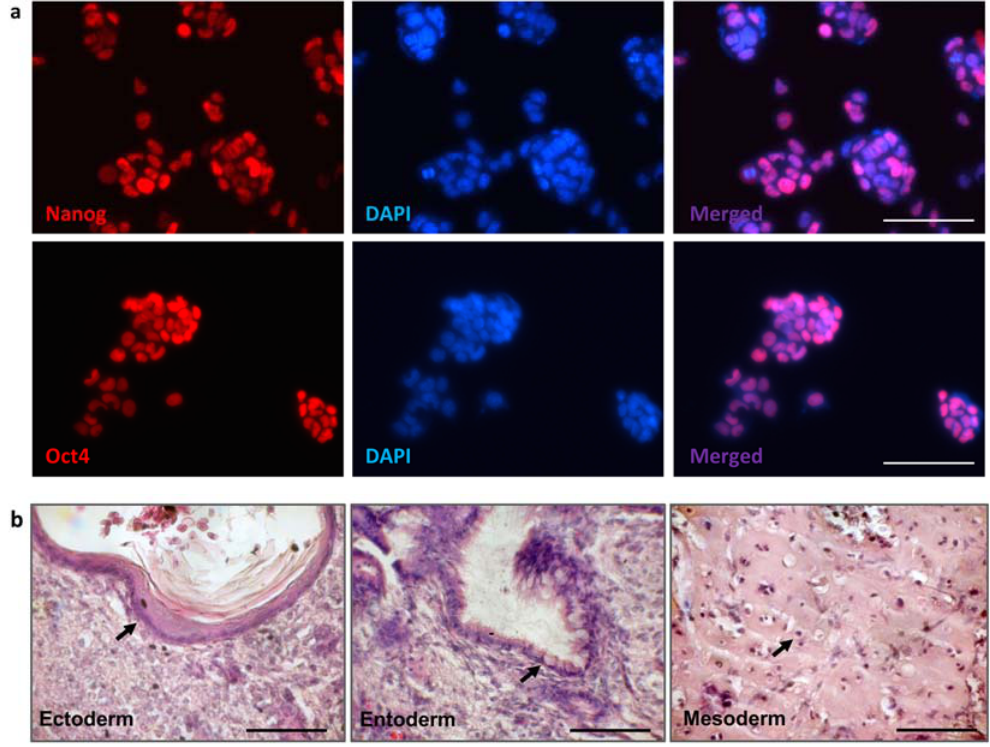
Figure 3. Expression of the pluripotency markers and teratoma formation by induced pluripotent stem cells (iPSCs) developed from FVIII Y / - fibroblasts. ( a ) Immunostaining of FVIII Y / - iPSCs with anti-Nanog antibodies (upper panel), and with anti-Oct4 antibodies (lower panel). Color-coded markers are indicated on the panels, scale bar—100 µ m. ( b ) Hematoxylin-eosin staining of the FVIII Y / - iPSC-derived teratomas with developed keratin epidermis of ectoderm, intestine epithelium of entoderm, and cartilage of embryonic mesoderm layers (indicated by arrows), scale bar—100 µ m.